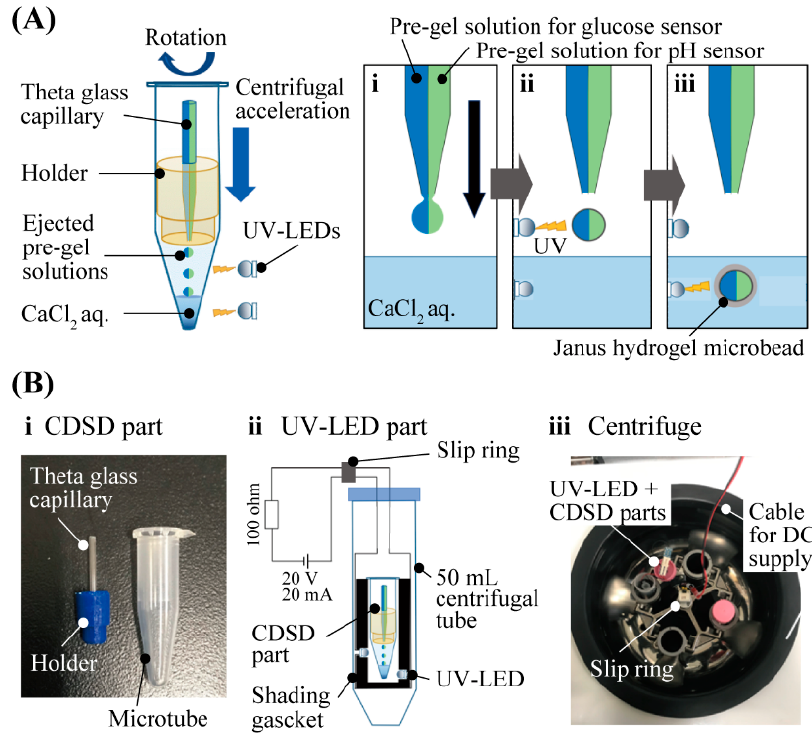
Figure 2. Fabrication of Janus hydrogel microbead sensor with CDSD with UV irradiation ( A ) Fabrication principle of Janus hydrogel microbeads. ( B ) Setup for the fabrication process. Using this method, the Janus hydrogel microbeads with glucose sensor and pH sensor were fabricated in a single centrifugal step (Figure 3A). Confocal fluorescent microscopic observation confirmed the Janus structure of the microbeads with the pH sensor part (green) on one side and glucose sensor part (blue) on the other side (Figure 3B). A thin alginate hydrogel shell, whose thickness could be controlled with UV irradiation power